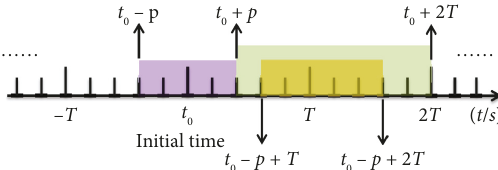
Figure 1: Relationship between interval length of deviating ar- gument and